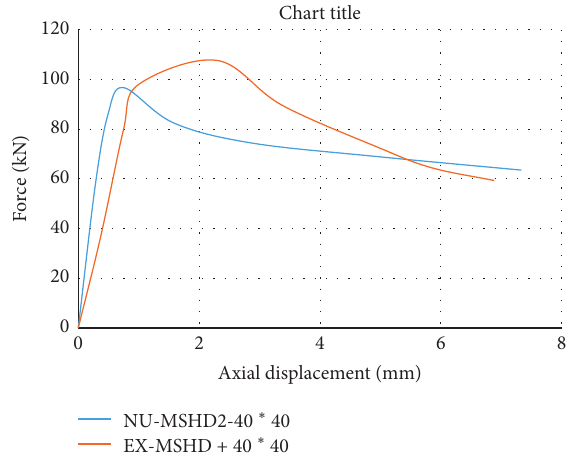
Figure 7: Force-displacement diagram of model and laboratory sample